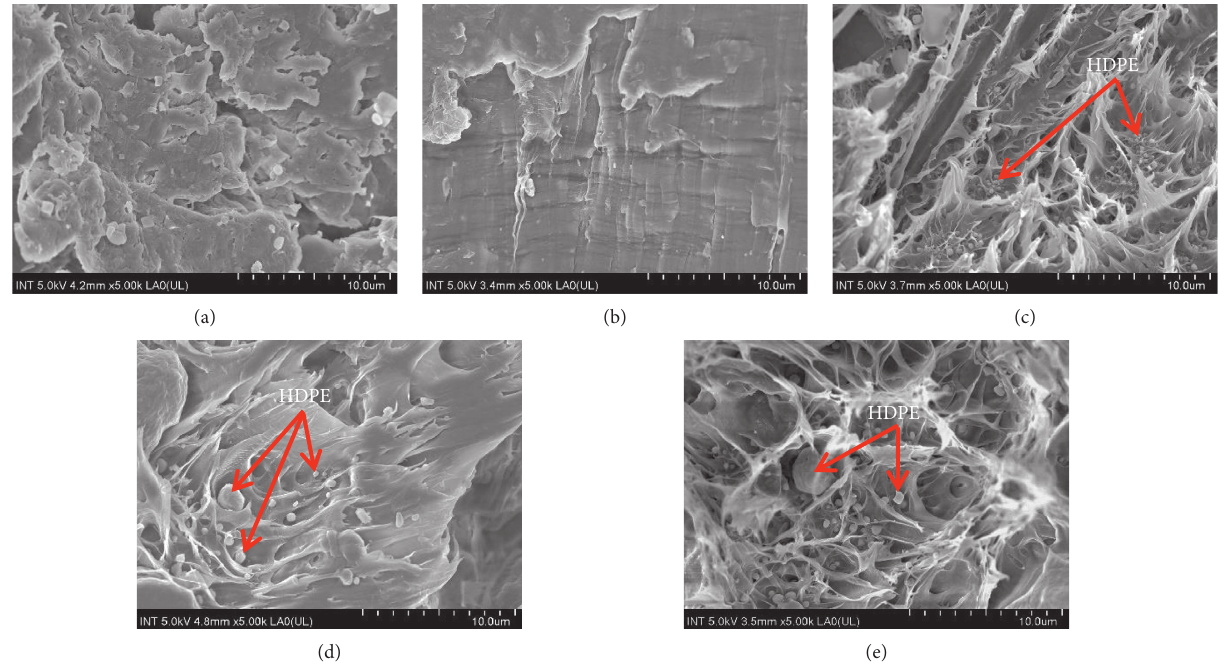
Figure 15: SEM micrographs of the PBT/HDPE blend with different weight percents of HDPE (5000 × magnification): (a) 0% HDPE (100% PBT), (b) 100% HDPE, (c) 5% HDPE, (d) 10% HDPE, and (e) 15%